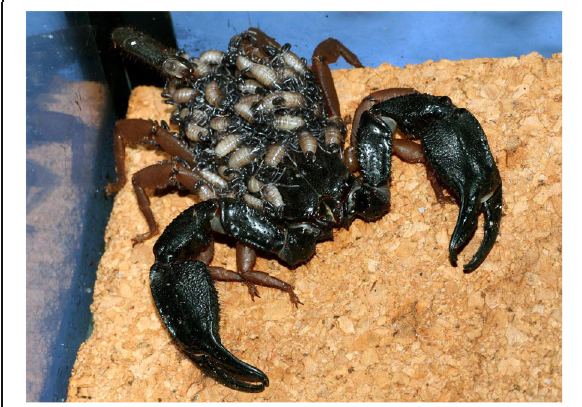
Fig. 15 A group of the social species Opisthacanthus cayaporum (hormurid) under UV